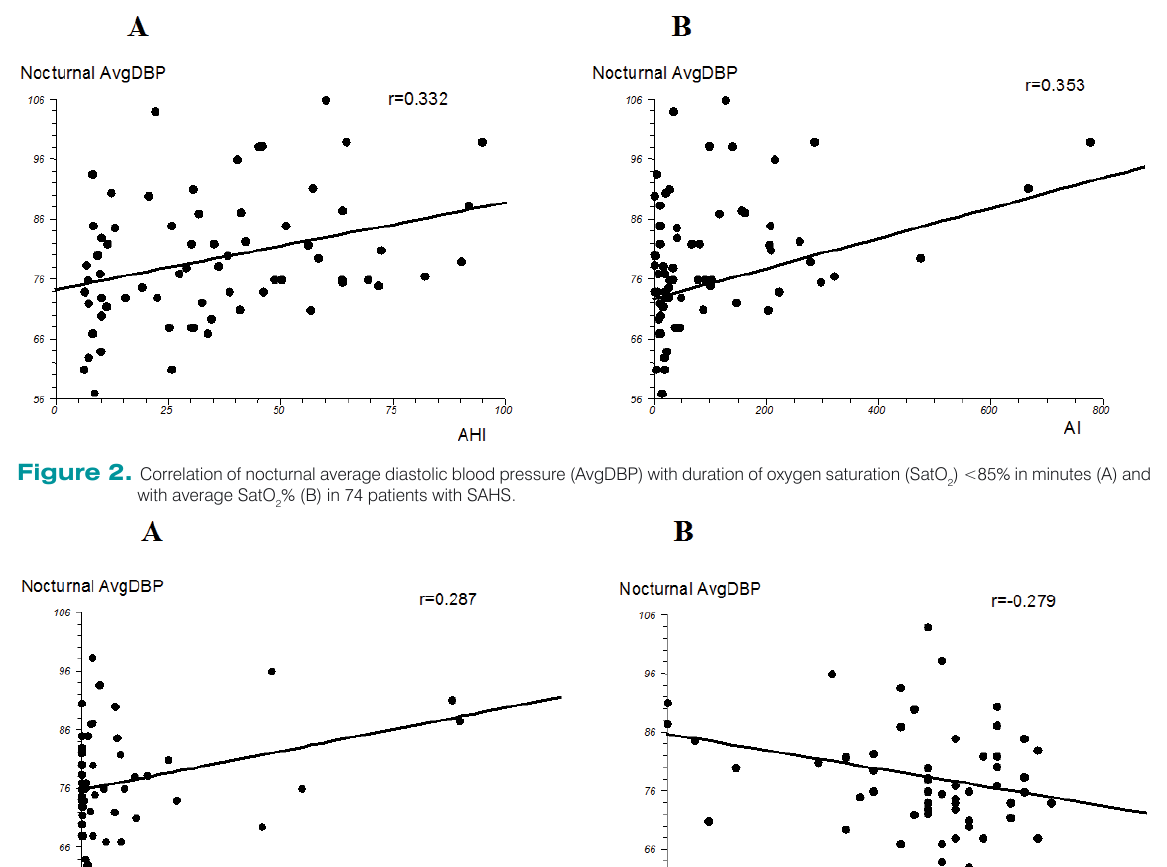
Figure 1. Correlation of nocturnal average diastolic blood pressure (AvgDBP) with apnea–hypopnea index (AHI, A) and with the number of apnea episodes (AI, B) in 74 patients with SAHS.